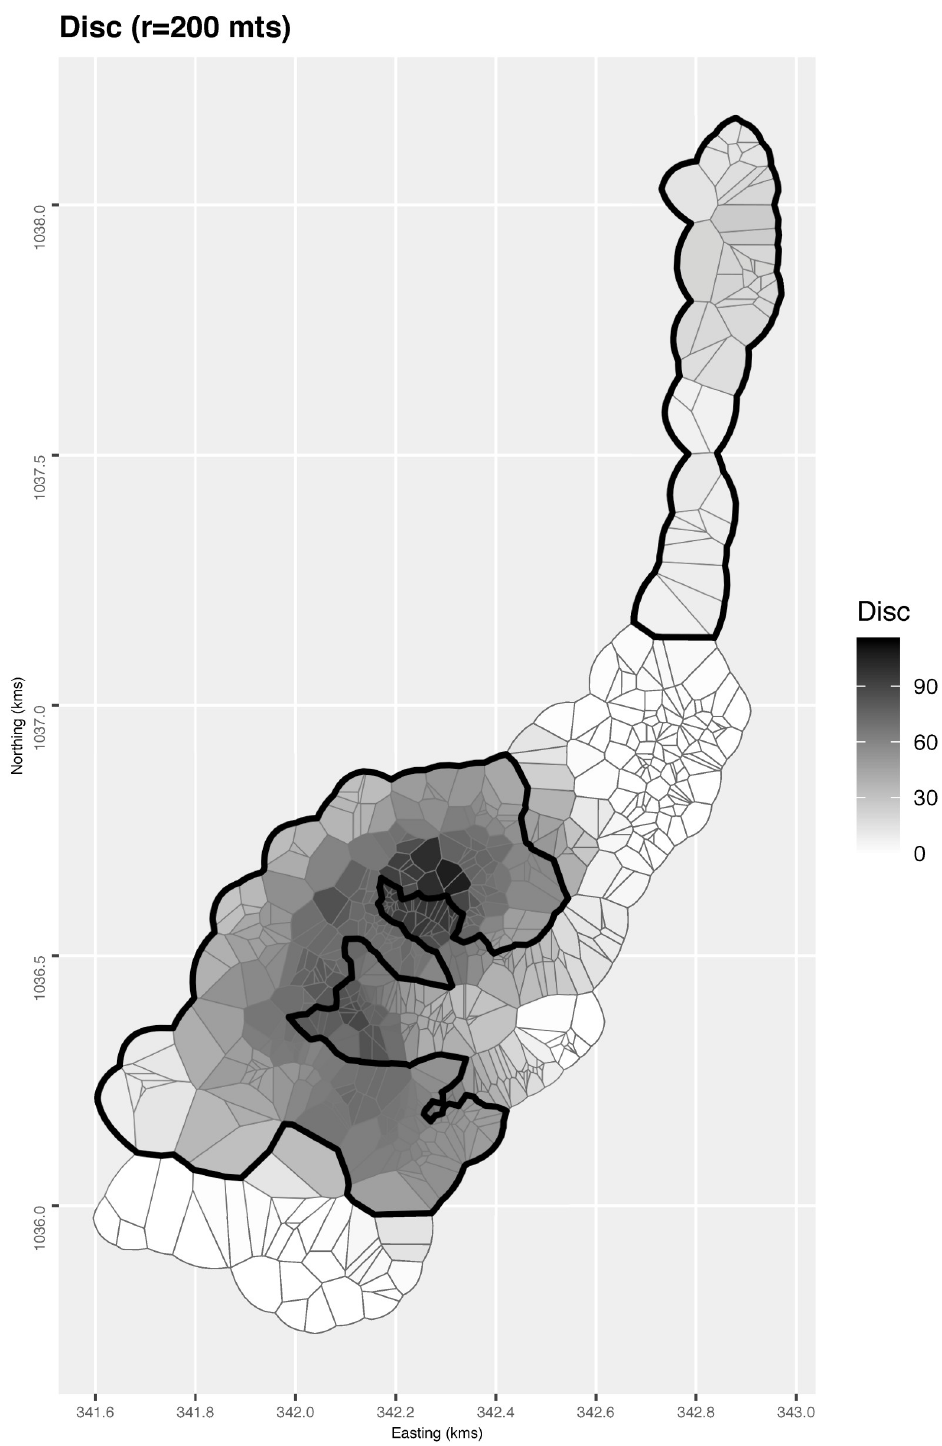
Fig 4. Choropleth map of the Dirichlet tiles around each location. Darker shadings indicate greater surroundedness by intervention locations according to the disc measure, i.e. number of intervention locations within a radius of 200m. Control regions are those inside the white